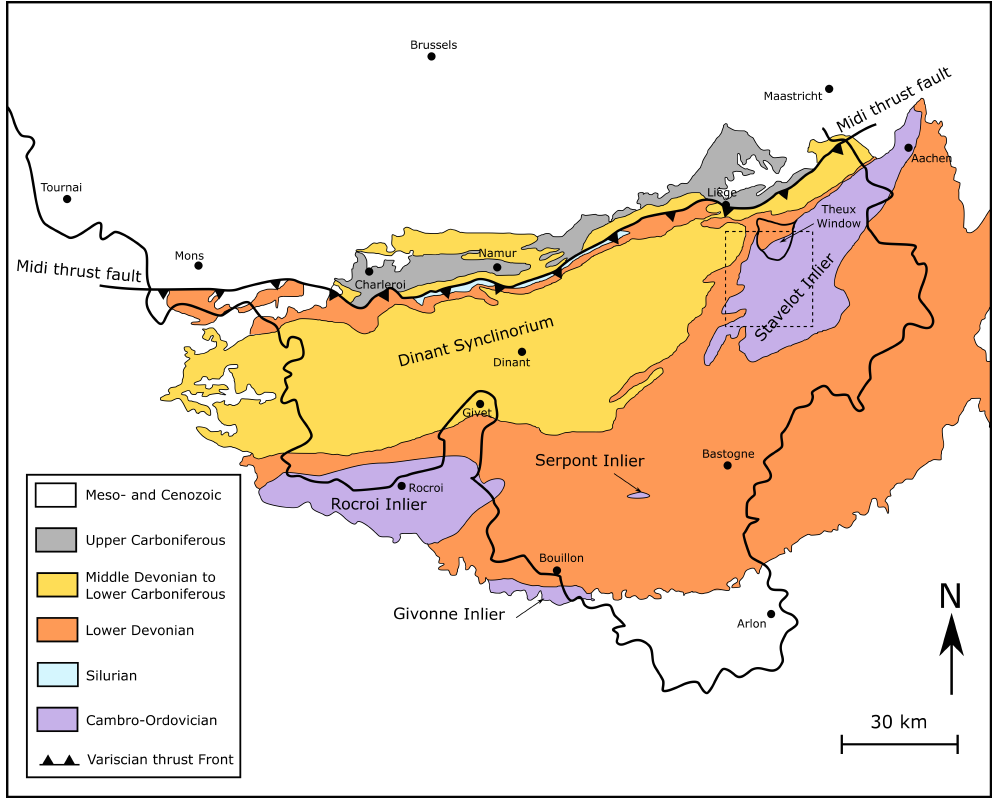
Figure 1. Regional geological context. The Stavelot Inlier is one of the inlier of the Ardenne anticlinorium formed by Cambro-Ordovician rocks unconformably overlaid by Devono-Carboniferous sandstones and limestones. The dashed rectangle indicates the study area (Figure 2) (modified after